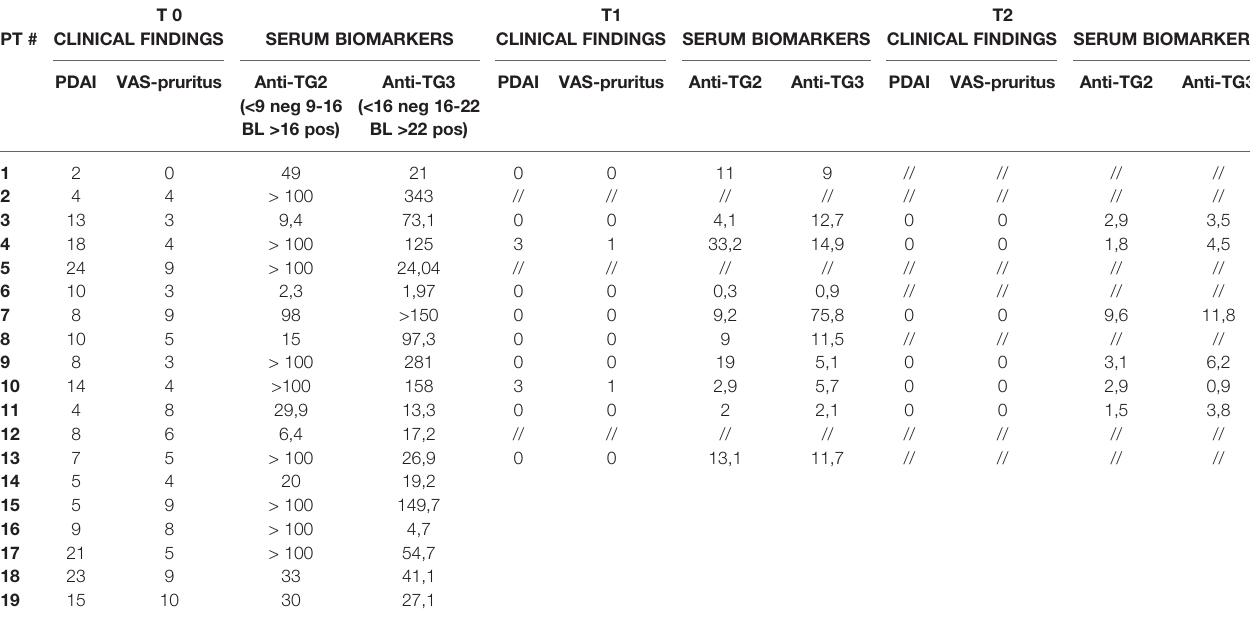
TABLE 3 | Clinical scores of disease activity in DH patients ’ follow up. T 0 T1 SERUM